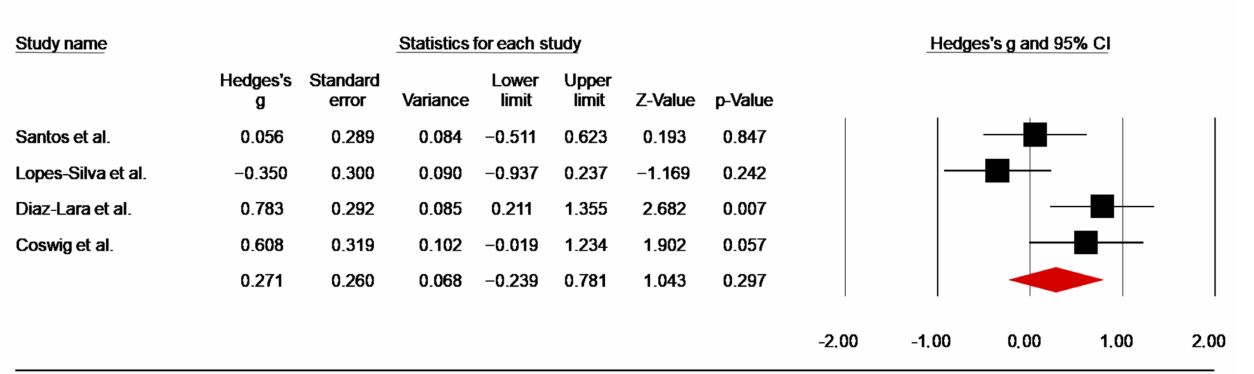
Figure 15. Forest plot of the effect of caffeine intake on duration of offensives actions during com- bat